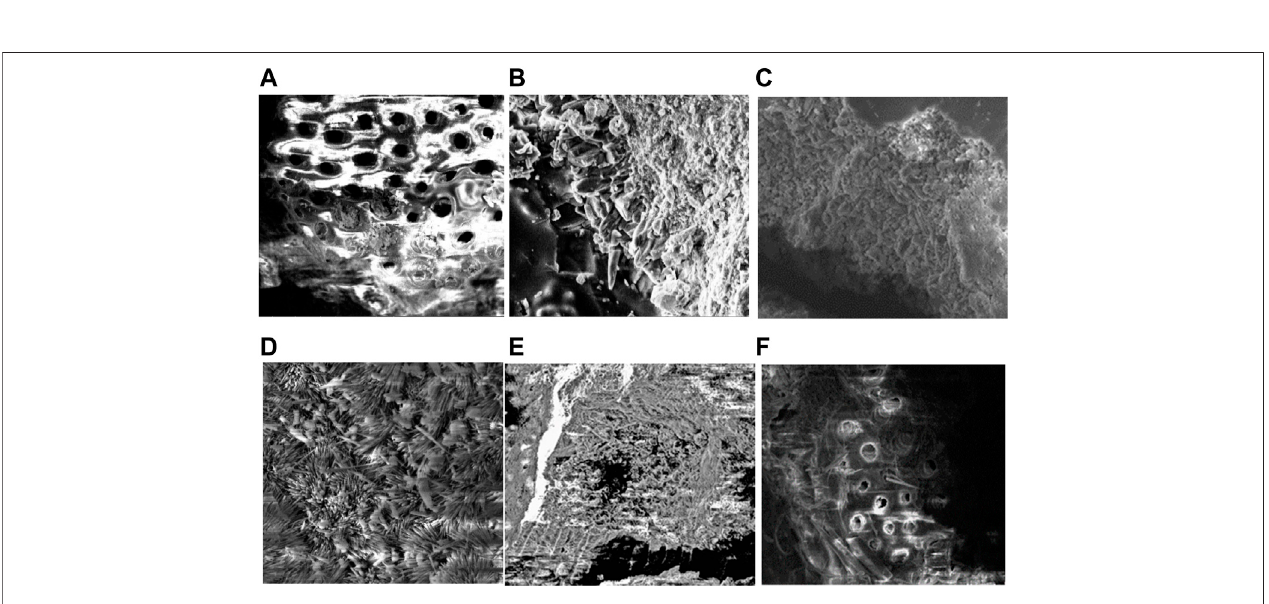
FIGURE 9 | Scanning electron microscopy (SEM) images of carbonate precipitation connected with coral sand from group B. (A) CaCl 2 (FW); (B) CaCl 2 (SW); (C) Ca(CH 3 COO) 2 (FW); (D) Ca(CH 3 COO) 2 (SW); (E) Ca(NO 3 ) 2 (FW); (F) Ca(NO 3 ) 2